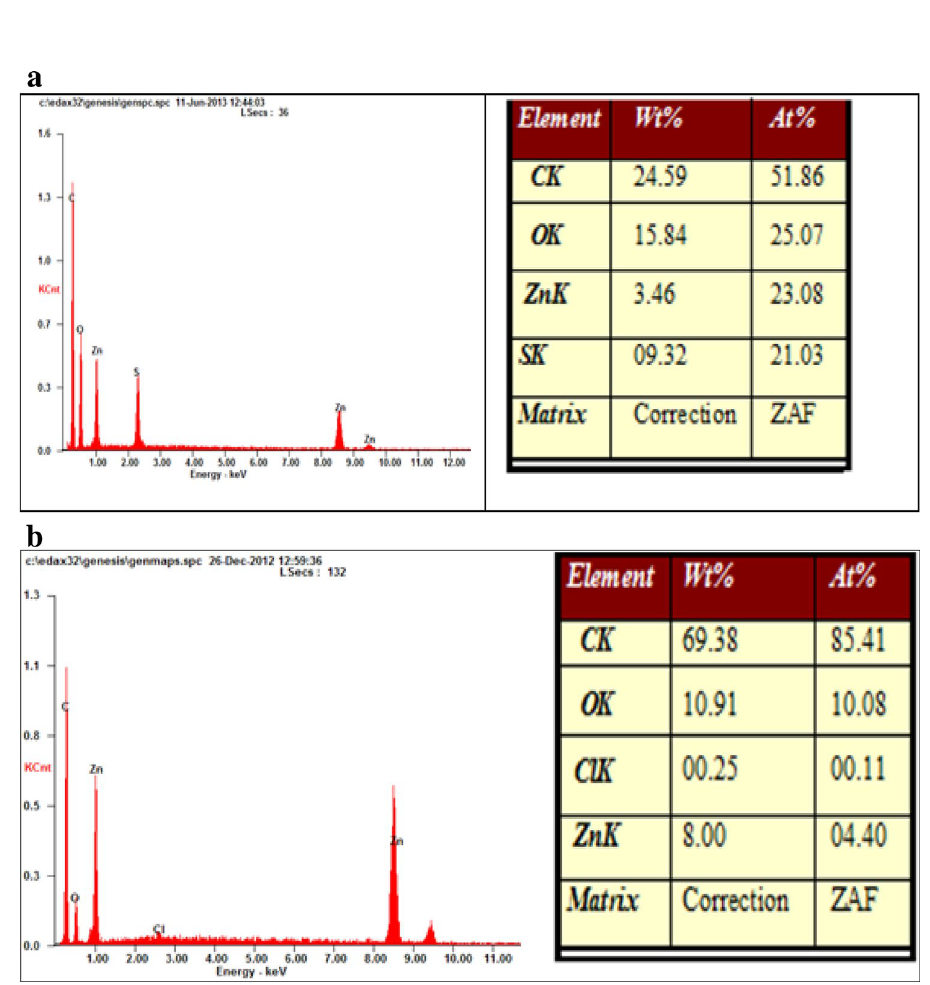
Figure 5. ( a) EDAX image of carbon sphere before loading Zn. ( b ) EDAX image of carbon sphere after loading